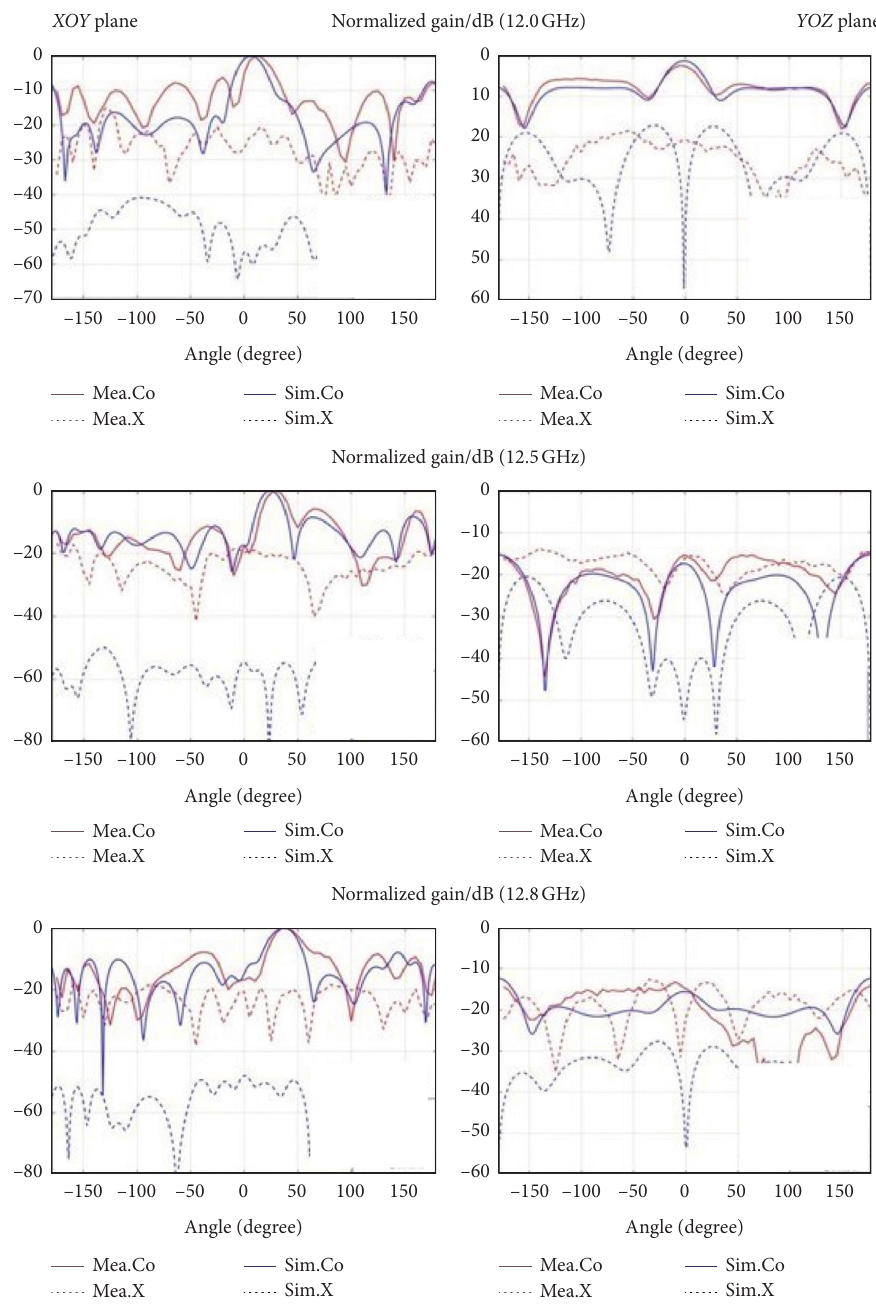
Figure 15: Radiation patterns at 12.0GHz, 12.5GHz, and 12.8GHz with both co- and cross-polarization components; red and blue lines represent the measured and simulated results, respectively. Mea.Co and Mea.X refer to the measured co-polarization and cross-polarization components, respectively, while Sim.Co and Sim.X represent the simulated